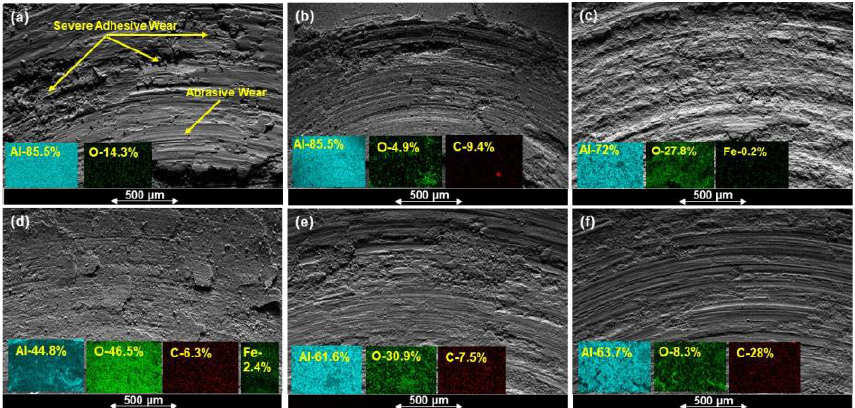
Figure 5. Variation of average coefficient of friction for all the tested samples at a load of 3 N, sliding speed of 0.1 m/s, and a sliding distance of 100 m.